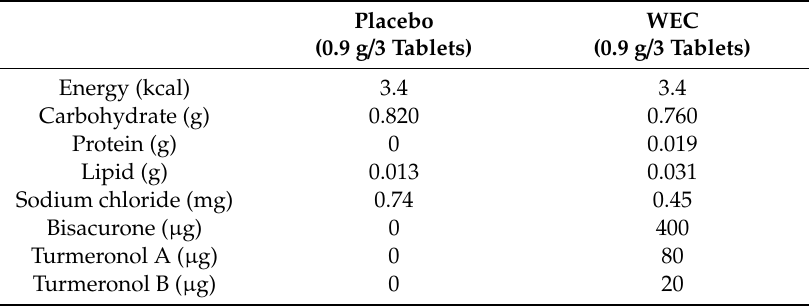
Table 1. Composition of the study tablets (per three